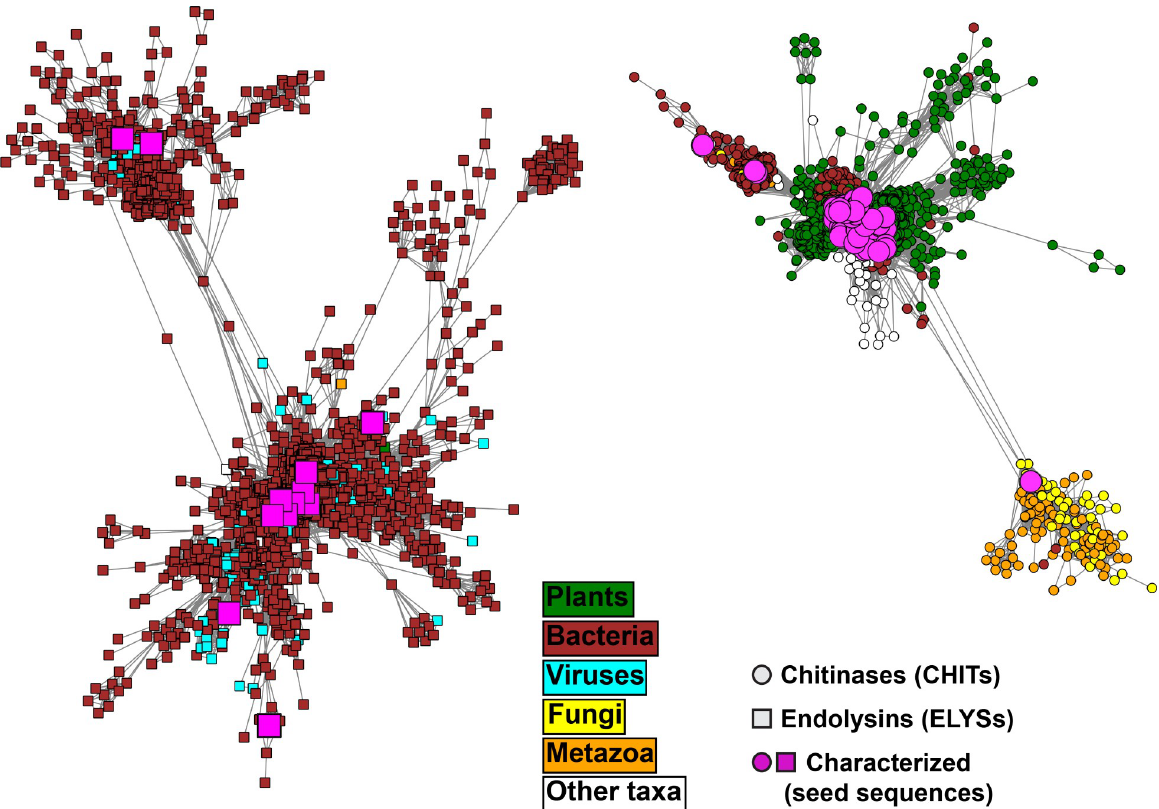
Fig 2. Protein sequence networks of representative domains of the two bigger clusters containing seed sequences (5067 nodes, 2329 nodes on the left for CHITs, chitinases, and 2738 nodes on the right for ELYSs, endolysins) connected by edges with a sequence identity threshold of 40%. The prefuse force-directed OpenCL layout with respect to the edge weights was used for network visualization. The domains were extracted by scanning the sequences collected through BLAST searches (using the seed sequences reported in S1 Table as queries) with the GH19 profile HMM PF00182 from Pfam. Nodes are colored according to their annotated taxonomic source. The remaining smaller network clusters are visualized in S5 Fig .